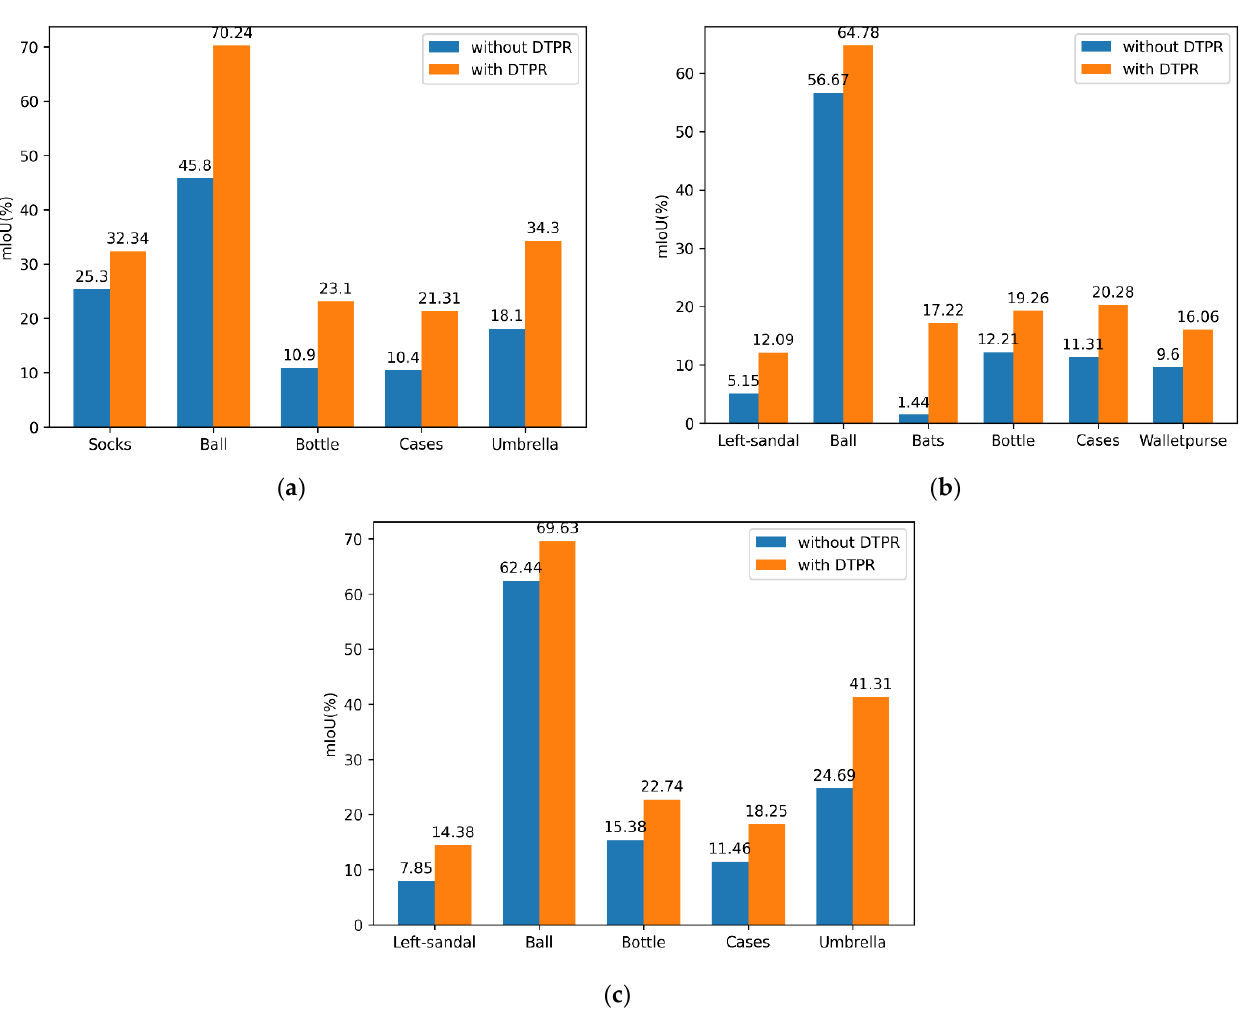
the semantic segmentation model. ( b ) Deeplab3+ is used as the semantic segmentation model. ( c ) DANet